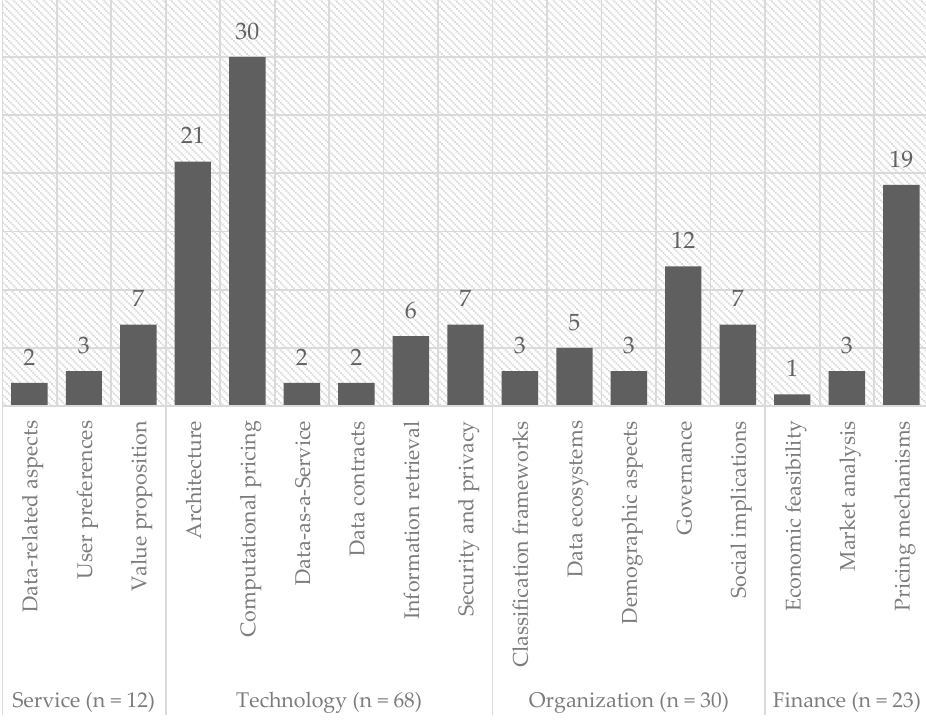
Figure 2. The selected articles categorized using the STOF model (n = 133).